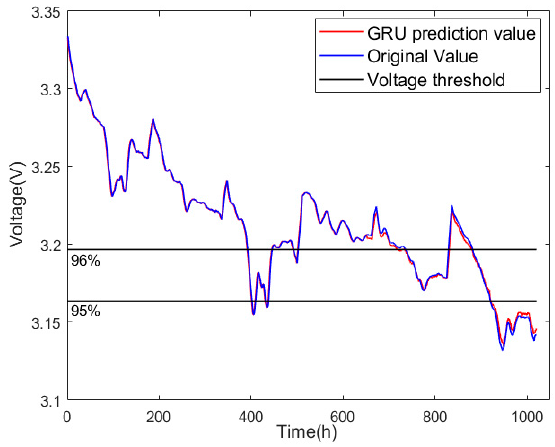
Figure 4. Prediction result of GRU.